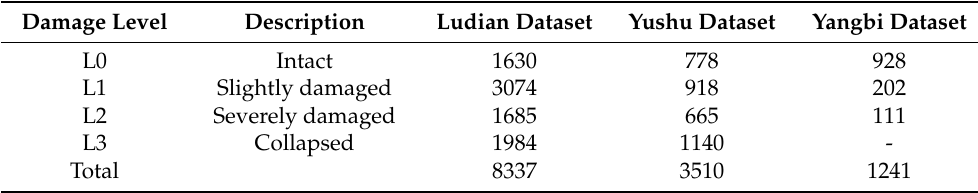
Table 1. Building examples and image information of the four damage levels in the datasets. Table 2. Statistics on the number of buildings sampled in the datasets with the four levels of dam- Table 2. Statistics on the number of buildings sampled in the datasets with the four levels of dam- Table 2. Statistics on the number of buildings sampled in the datasets with the four levels of dam- age. age. age. Table 2. Statistics on the number of buildings sampled in the datasets with the four levels of dam- age. Table 2. Statistics on the number of buildings sampled in the datasets with the four levels of dam- age. Table 2. Statistics on the number of buildings sampled in the datasets with the four levels of dam- Table 2. Statistics on the number of buildings sampled in the datasets with the four levels of dam- age. age. Table 2. Statistics on the number of buildings sampled in the datasets with the four levels of dam- age. Table 2. Statistics on the number of buildings sampled in the datasets with the four levels of dam- Table 2. Statistics on the number of buildings sampled in the datasets with the four levels of dam- age. age. Table 2. Statistics on the number of buildings sampled in the datasets with the four levels of dam- age.